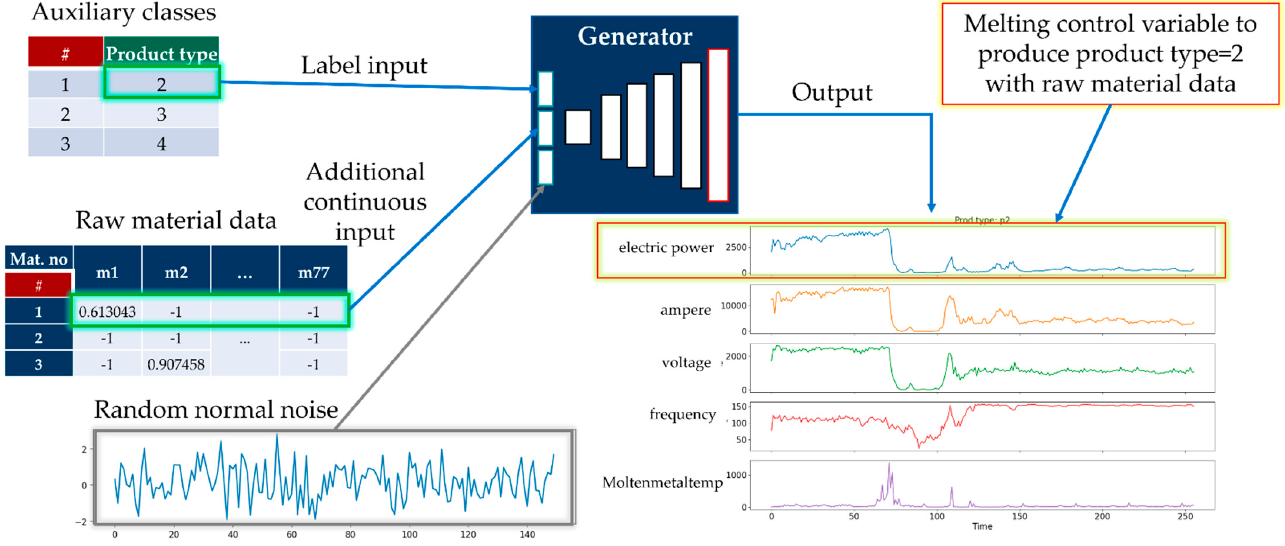
Figure 4. The generator model of AC ‐ GAN for the melting process.